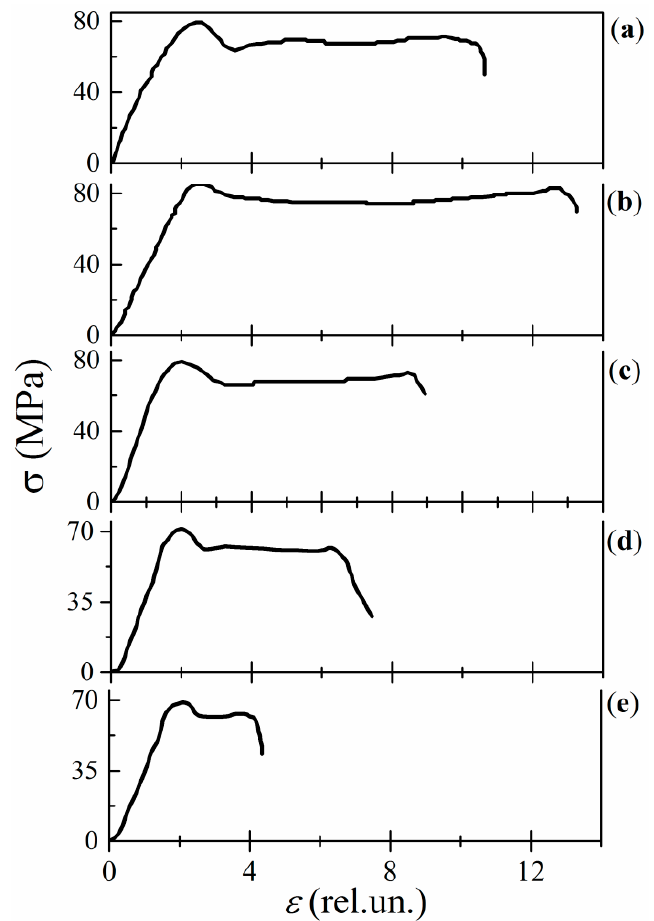
Figure 4. Stress–strain curves for the neat resin ( а ) and MLG composites of 0.01% ( b ), 0.1% ( c ), 0.5% ( d ), and 1% ( e ) MLGs.